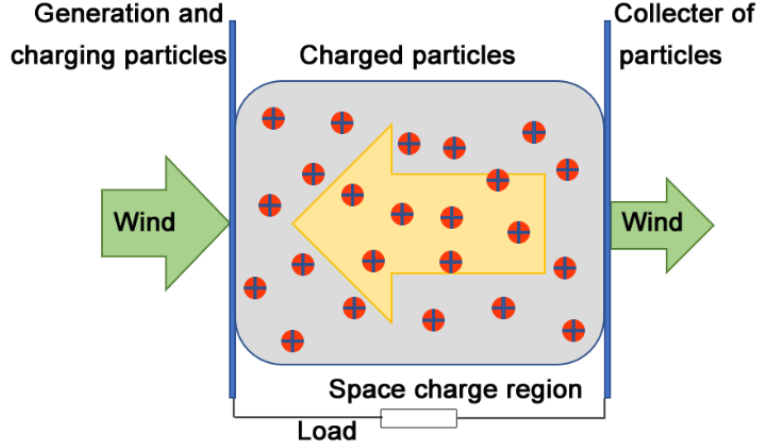
Figure 4. Bladeless electrostatic wind energy converter mechanism. (Reproduced with permission [37]. Copyright 2015, CI TASK).